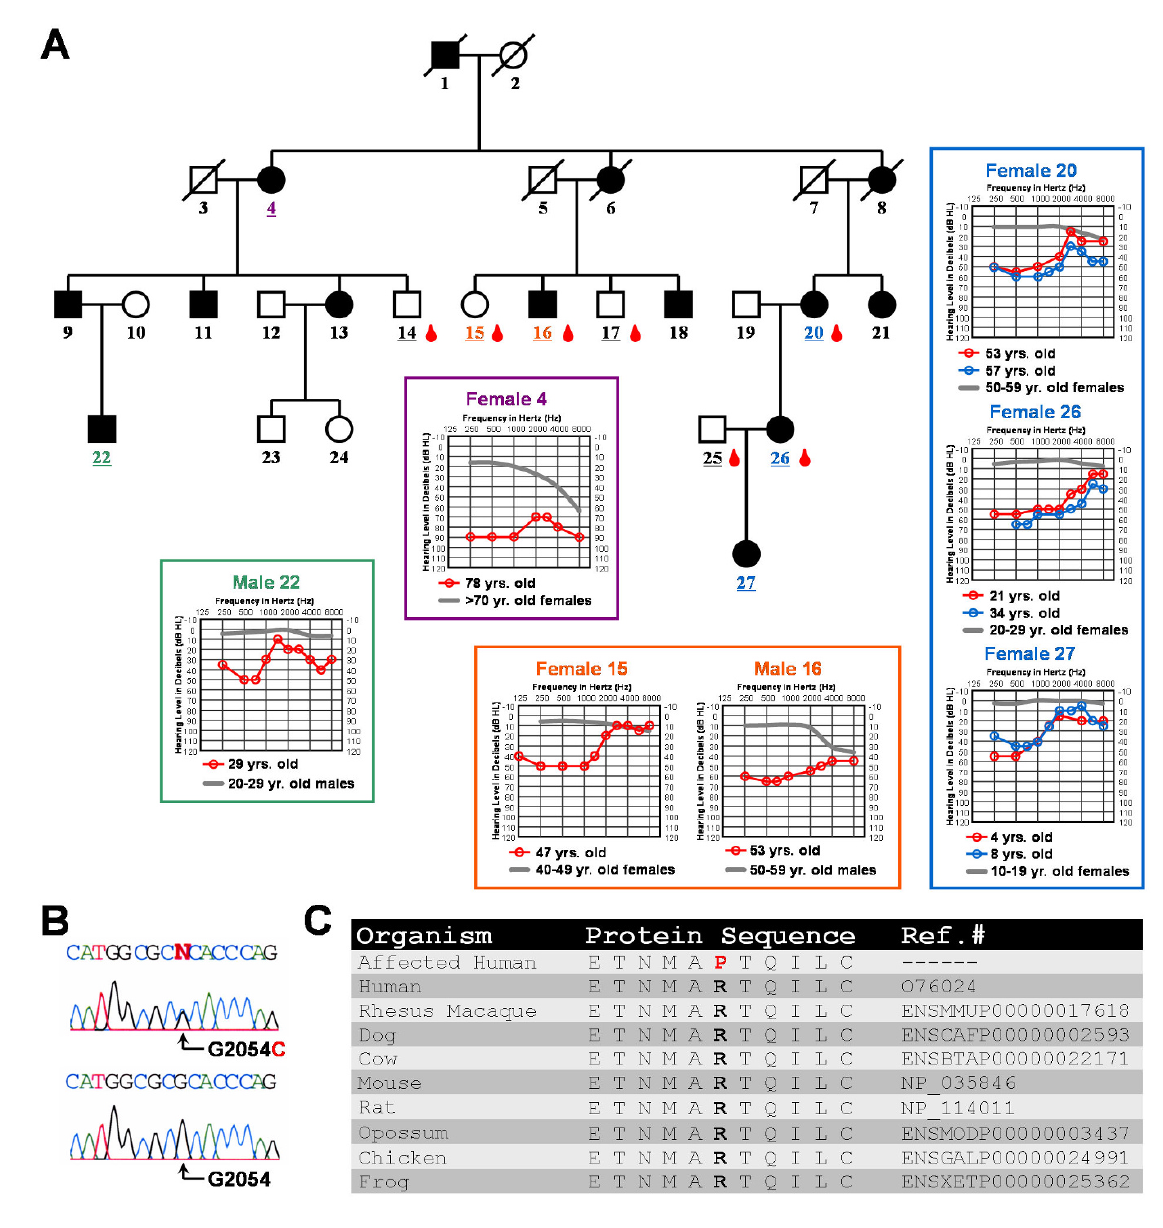
Figure 1 Audiologic and genetic characterization of the low frequency hearing loss pedigree. (A) Each individual in the ped- igree is assigned a number. Underlined numbers indicate that auditory evaluations were performed for that person. Affected individuals are denoted by blackened symbols, males are denoted by squares, females are denoted by circles, and deceased per- sons are indicated by a diagonal line through the symbol. Blood drop symbols indicate individuals who donated a blood sample to the study. Symmetrical hearing loss was detected in all affected family members; therefore, only the right ear pure-tone air conduction thresholds are plotted on the audiograms. Frequency in hertz (Hz) is plotted on the x-axis and the hearing level in decibels (dB HL) on the y-axis. Plotted on each audiogram (gray line) are the average pure-tone air conduction thresholds for a person with normal hearing matched in age [39] to the family member. (B) Electropherograms showing a heterozygous c.2054G>C mutated genomic nucleotide sequence from an affected individual compared to a homozygous c.2054G unaffected family member. Nucleotide numbering starts with the ORF. (C) Protein alignment shows conservation of the p.R685 residue during evolution. The p.685P substitution in the pedigree is shown in